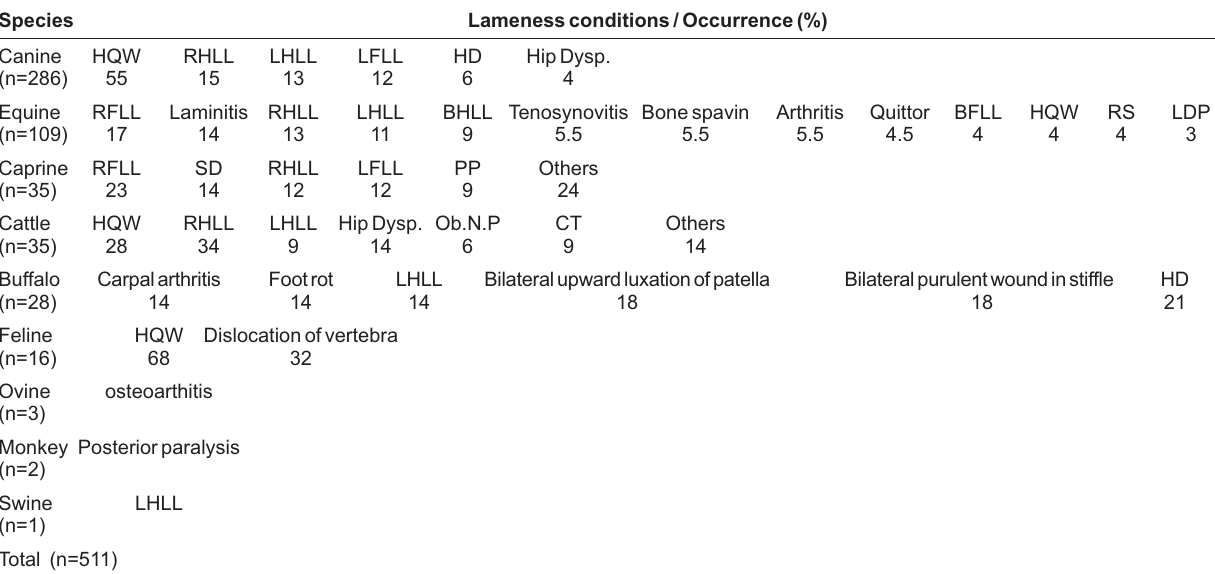
Table-1: Incidence of lameness reported in different species during the study.